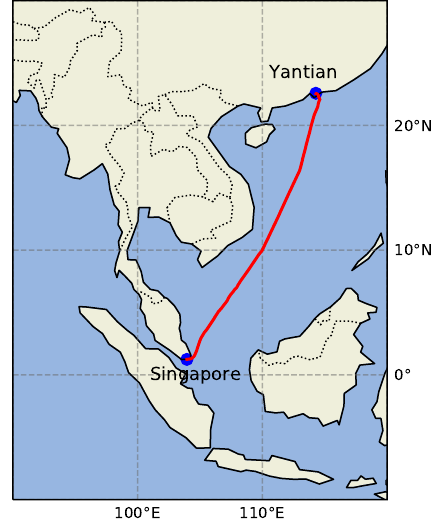
Figure 9. Navigational route of the target